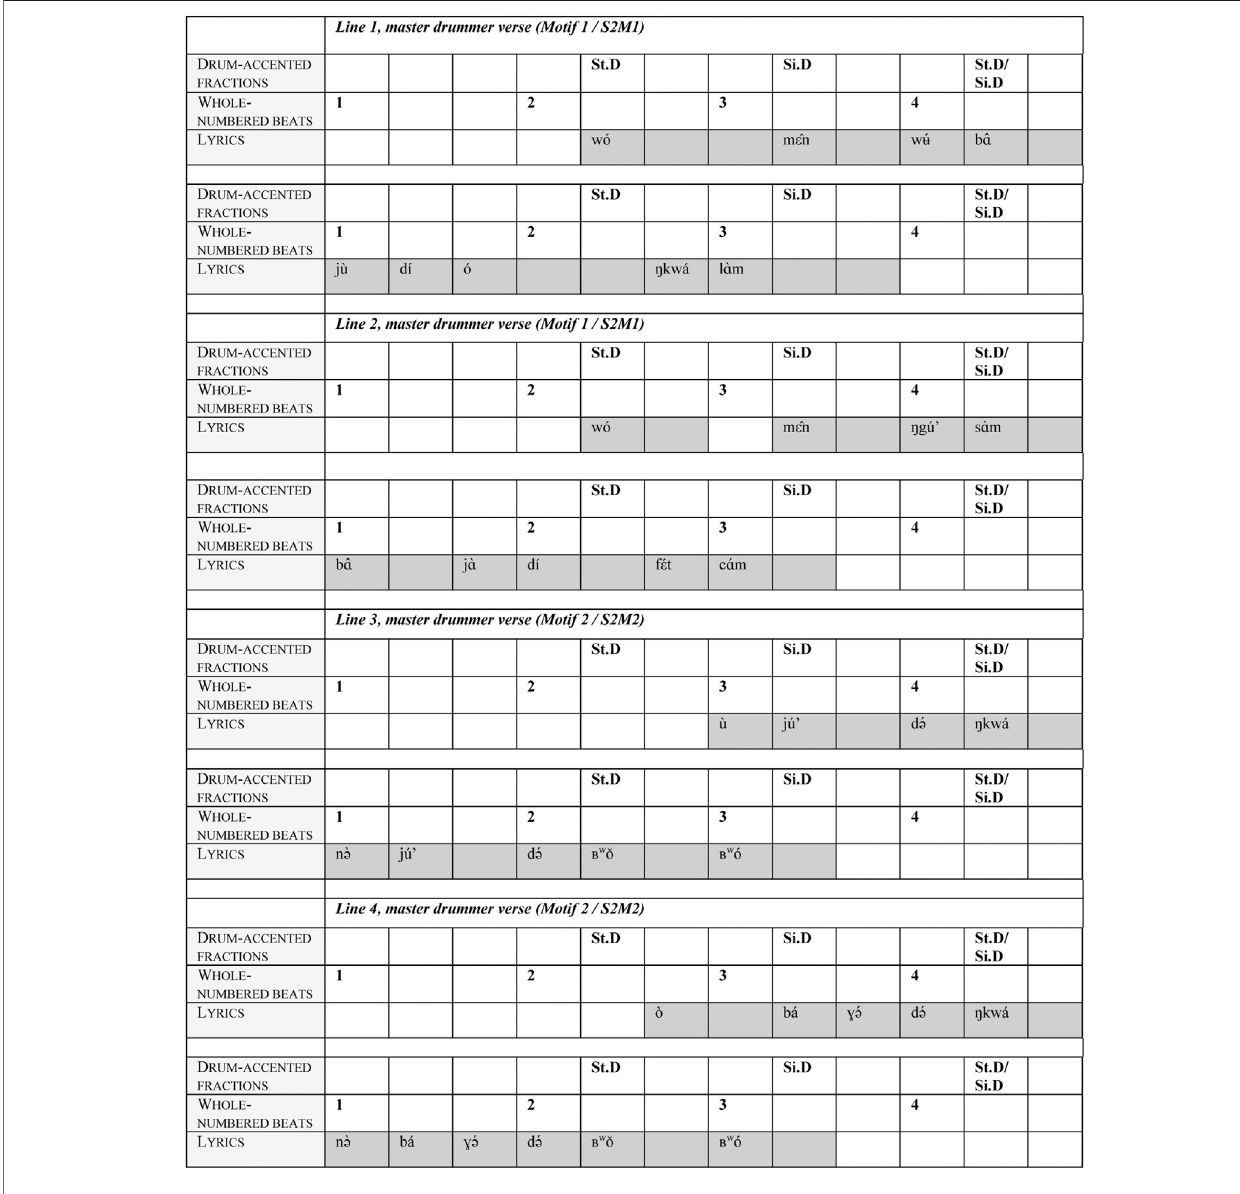
FIGURE 13 | Grid representation of three lines of master drummer ’ s verses, Song 2. Numbers 1 – 4 represent whole-numbered beats on which the idiophone/ shaker sound and dancers move. Individual cells represent beats on which the complex ndu (cid:3) nlàm/metallophone sounds. St/Si represent beat fractions on which the Standing or Sitting drum sounds. Gray fi lled cells indicate beats on which the voice is